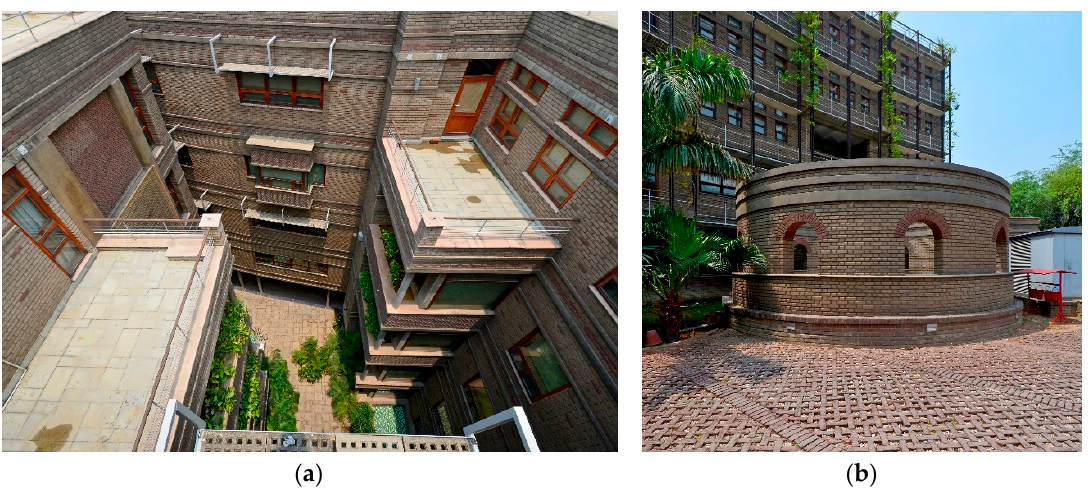
Figure 24. Shallow domed ceilings span the interior spaces of the DA building (Photo: Author).